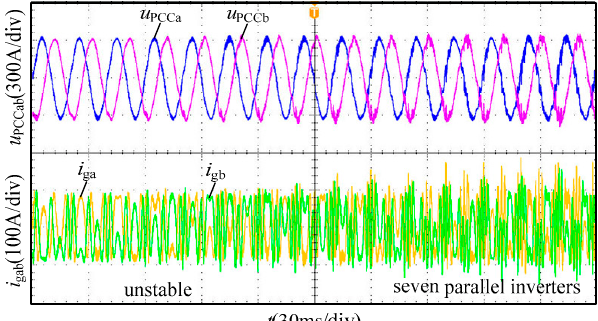
Figure 19. Experimental waveforms of PCC voltage u PCC and the grid-connected current i g in case I (seven parallel inverters).